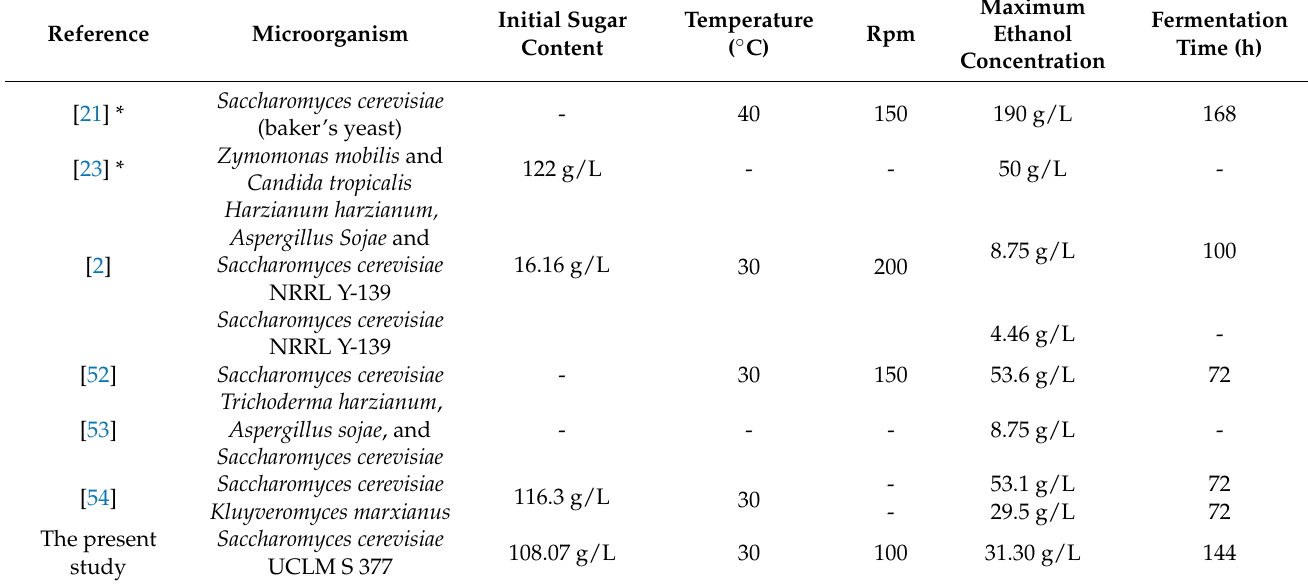
Table 3. Results comparison with other bioethanol production studies from apple